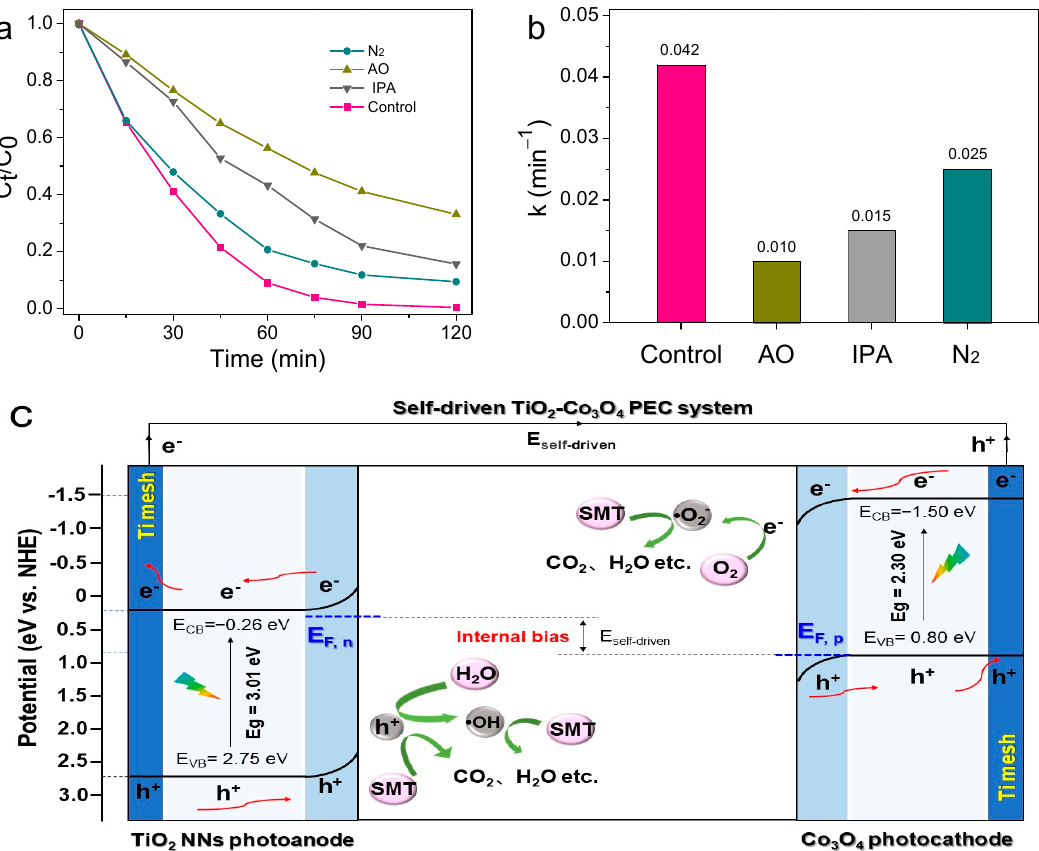
Figure 7. Effects of different quenching scavengers on SMT degradation efficiency ( a ) and reaction rate constant ( b ). Possible mechanism of SMT degradation of unbiased TiO 2 NNs-Co 3 O 4 PEC system under visible LED light irradiation ( c ).